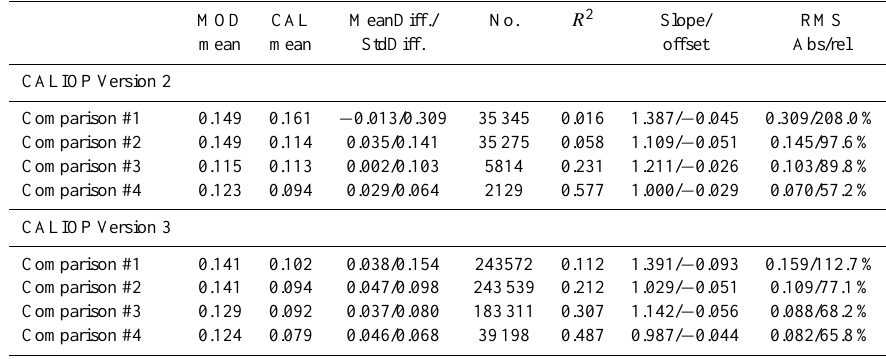
Table 5. MODIS vs. CALIOP AOD532, October 2007, over-ocean. MOD CAL MeanDiff./